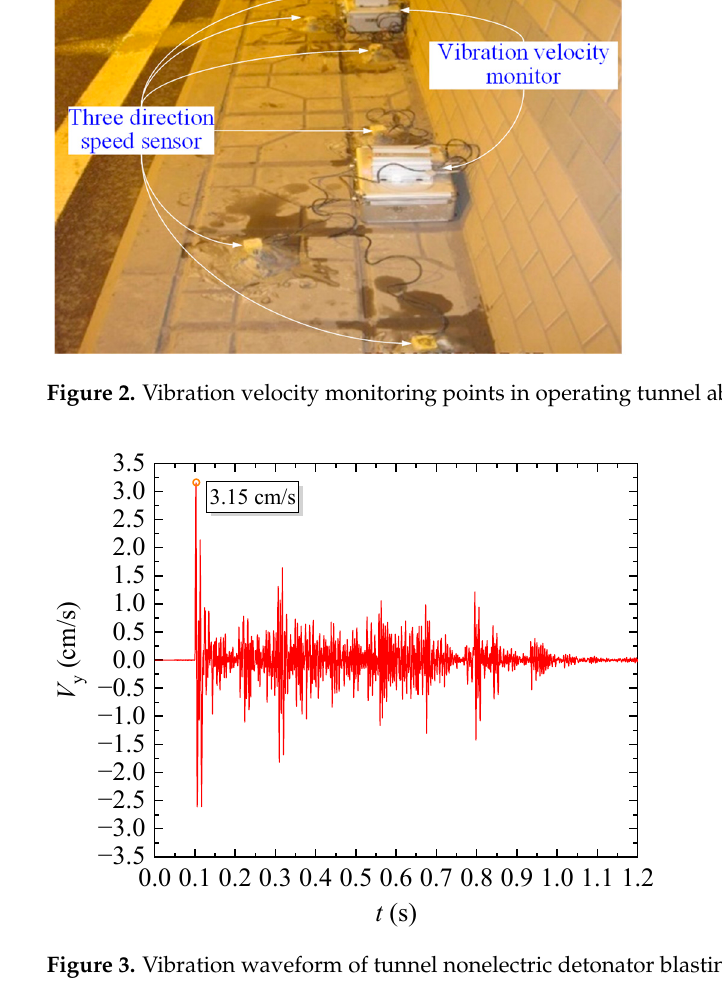
Figure 5. Blasting vibration velocity waveform of tunnel electronic detonators. The maximum vibration velocity is 3.15 cm/s when the nonelectric detonators are used, and the maximum vibration velocity is reduced to 1.51 cm/s after the electronic det- onator test, as shown in Figures 3 and 5, respectively. The maximum vibration velocity caused by electronic detonators is about 52.1% lower than that caused by nonelectric det- onators, and the decrease is obvious. An important factor affecting the damage of sur- rounding rock is the maximum vibration velocity generated by cutting blasting. However, the maximum vibration velocity is randomly generated in a blast hole when using elec- tronic detonators. Therefore, vibration reduction measures such as drilling empty holes to reduce cut blasting do not have advantages in the use of electronic detonator initiation. Another important reason is that the nonelectric detonator initiation delay accuracy is not easy to control. The delay parameter error of the design based on the burning velocity of the explosive is large, which makes it necessary to detonate multiple holes at the same time. On the contrary, the delay accuracy of electronic detonators has been significantly improved. It can realize the sequential initiation of single hole without considering the influence of cumulative error. In this way, the amount of explosive detonated at the same